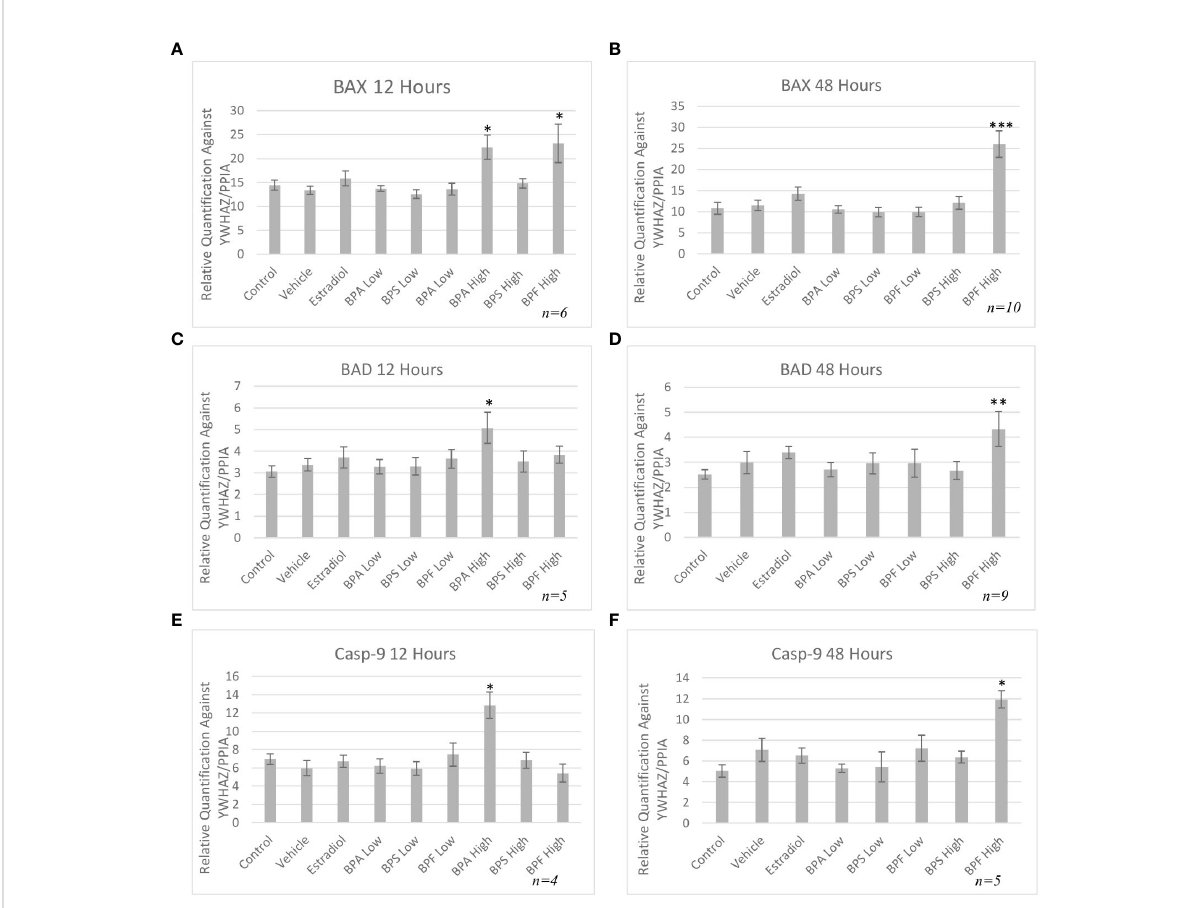
FIGURE 5 Pro-apoptotic mRNA expression after treatment with bisphenols. BAX 12 (A) and 48 (B) hours, BAD 12 (C) and 48 (D) hours, and Casp-9 12 (E) and 48 hours (F) mRNA in granulosa cells after treatment at a low (0.5 m g/mL) and high (50 m g/mL) dose of BPA, BPS, and BPF. Quanti fi cation relative to reference genes YWHAZ and PPIA. *p<0.05,**p<0.01, and ***p<0.001 compared to controls was considered as statistically signi fi cant. Error bars represent +/-